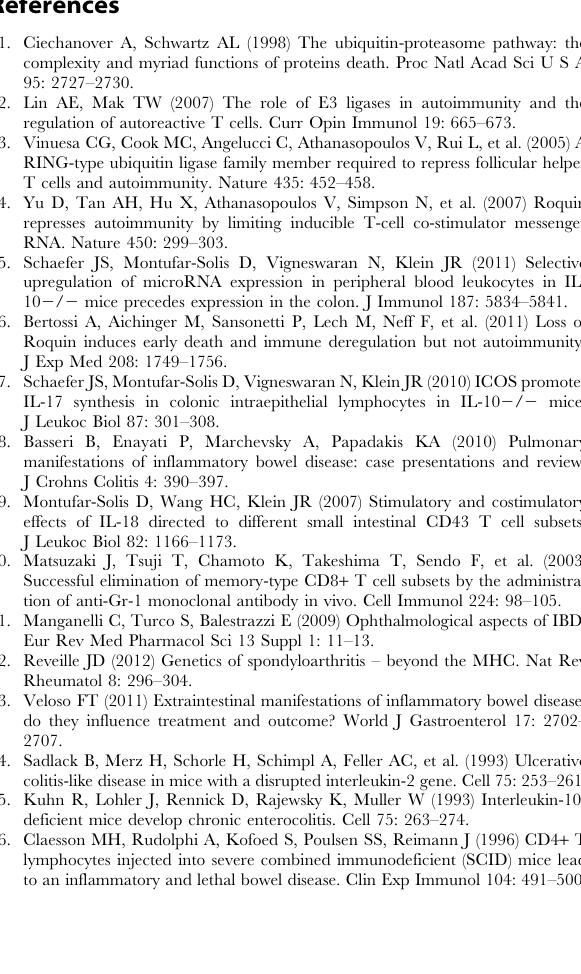
Figure S1 Location of gene trap insertion into intron 1 of the Rc3h1 allele. Black nucleotides are intron sequences. Green nucleotides are b -geo gene trap insert